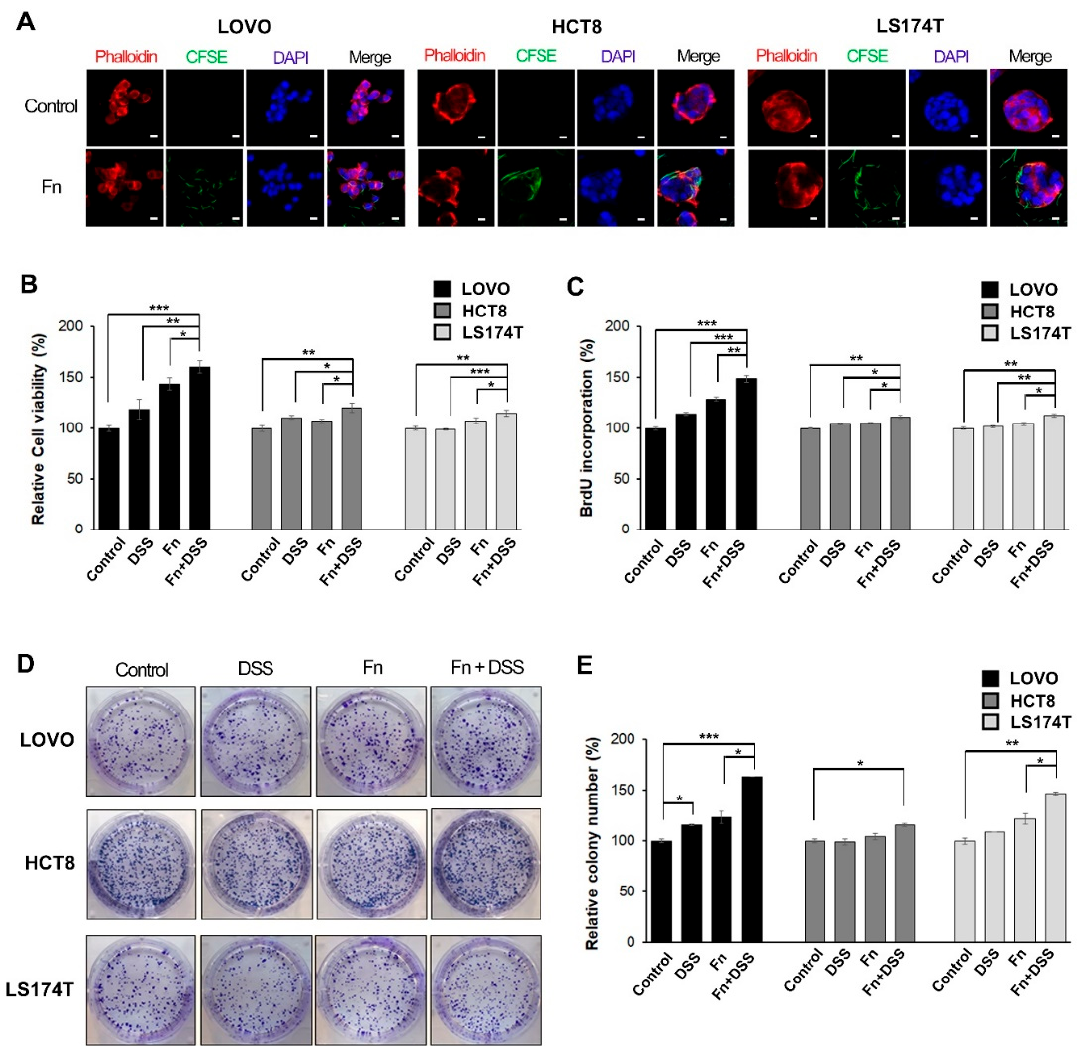
Figure 1. F. nucleatum promotes growth in colorectal cancer (CRC) cells under DSS stimulation. ( A ) LOVO, HCT8, and LS174T colorectal cancer cells (CRCs) were infected with carboxyfluorescein succinimidyl ester (CFSE)-labeled F. nucleatum (green) for 3 h before analysis using confocal microscopy. The plasma membrane (rhodamine-phalloidin) and nucleus (DAPI) were stained red and blue, respectively. CFSE-labeled F. nucleatum was found mainly in the cytosol or the boundary of the cell; 200 times magnification; scale bar: 10 µ m. ( B ) CRC cells were incubated with the vehicle, DSS, F. nucleatum , or DSS + F. nucleatum . Cell-proliferation rates were evaluated using MTT assays. ( C ) Proliferation was assessed using a BrdU incorporation assay. Relative changes in the percentage of the absorbance at 450 nm compared to that in the uninfected control. ( D ) Images showing the effect of F. nucleatum on the colony-forming ability of CRC cells. ( E ) Graphical representation of the number of colonies formed expressed as percentage of the control. The graph represents relative levels from three independent experiments. The data are presented as the mean ± SEM (* p < 0.05, ** p < 0.01, and *** p < 0.001; unpaired Student’s t -test). Abbreviations: DSS, dextran sodium sulfate; Fn, F. nucleatum